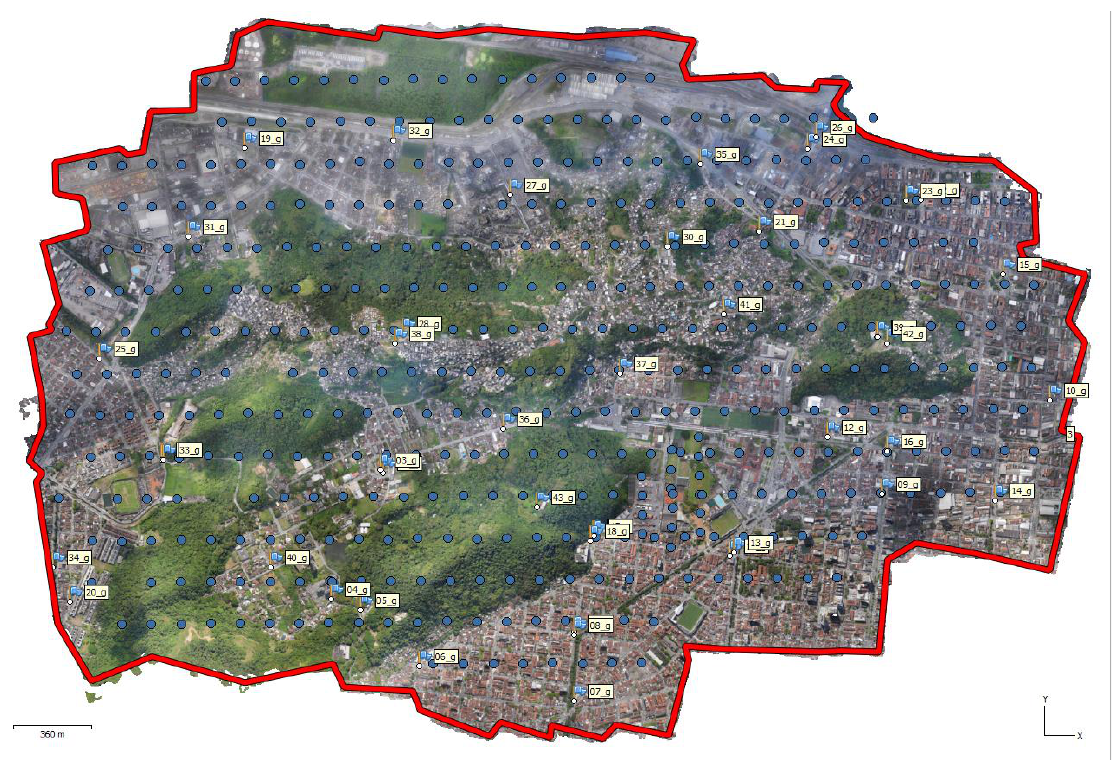
Figure 6 – Printing of the orthophoto generated for the study